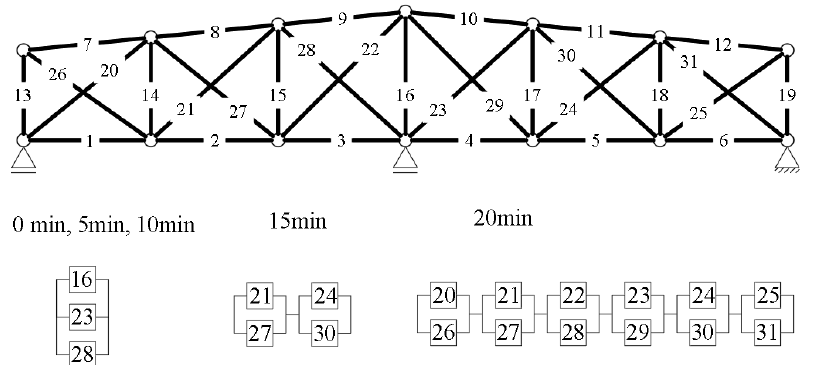
Figure 9. Statically indeterminate structure with six degrees of freedom with intermediate support (Truss 2) and corresponding cut-sets.